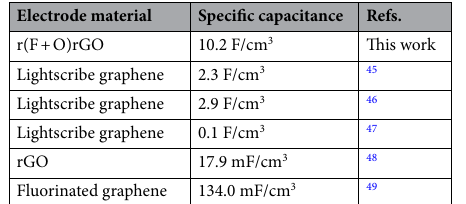
Electrode material Specific capacitance